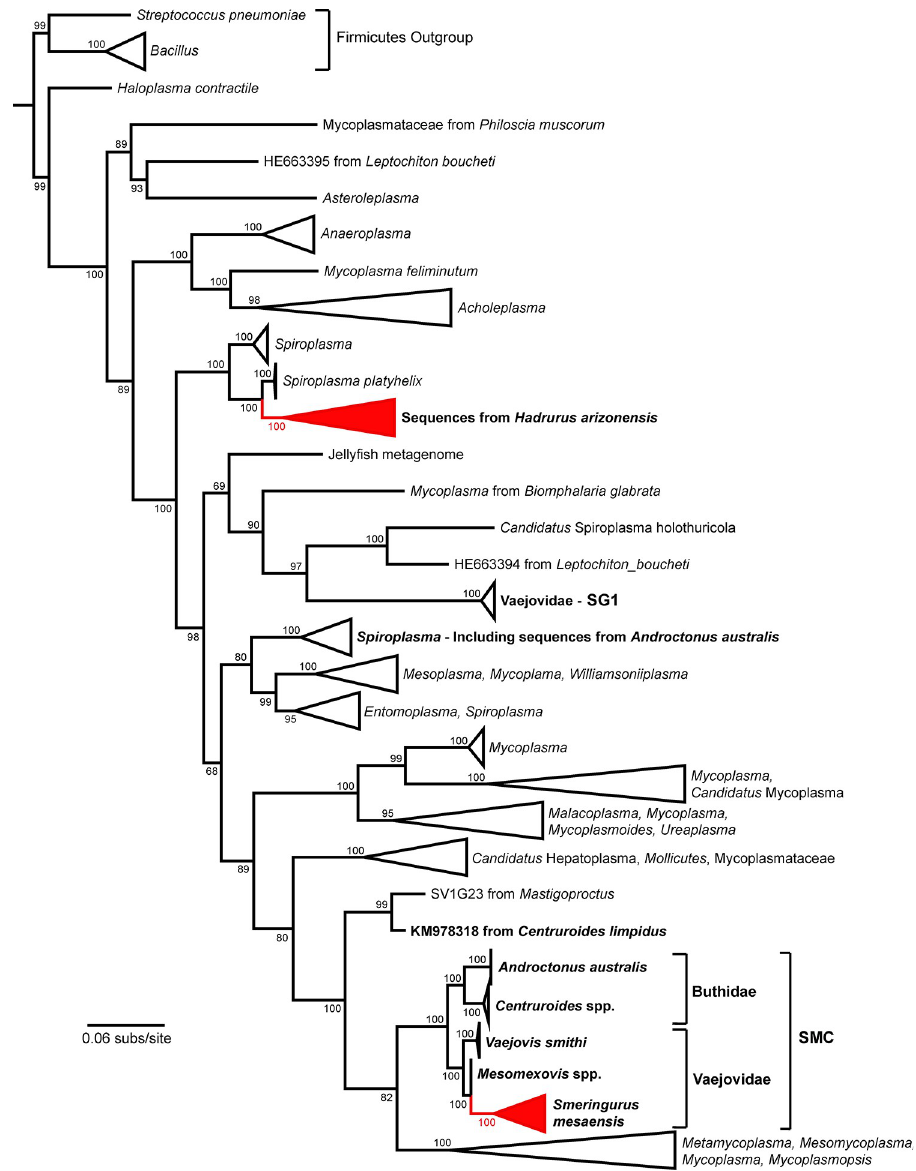
Fig 4. Phylogenetic tree of Mollicutes 16S rRNA. The phylogenetic tree was constructed using Maximum Likelihood, including a total of 312 sequences representing Mollicutes taxa. Scorpion sequences are in bold. Red collapsed regions indicate 12 sequences reported in this study from H . arizonensis and S . mesaensis . For an expanded version of this figure see S2